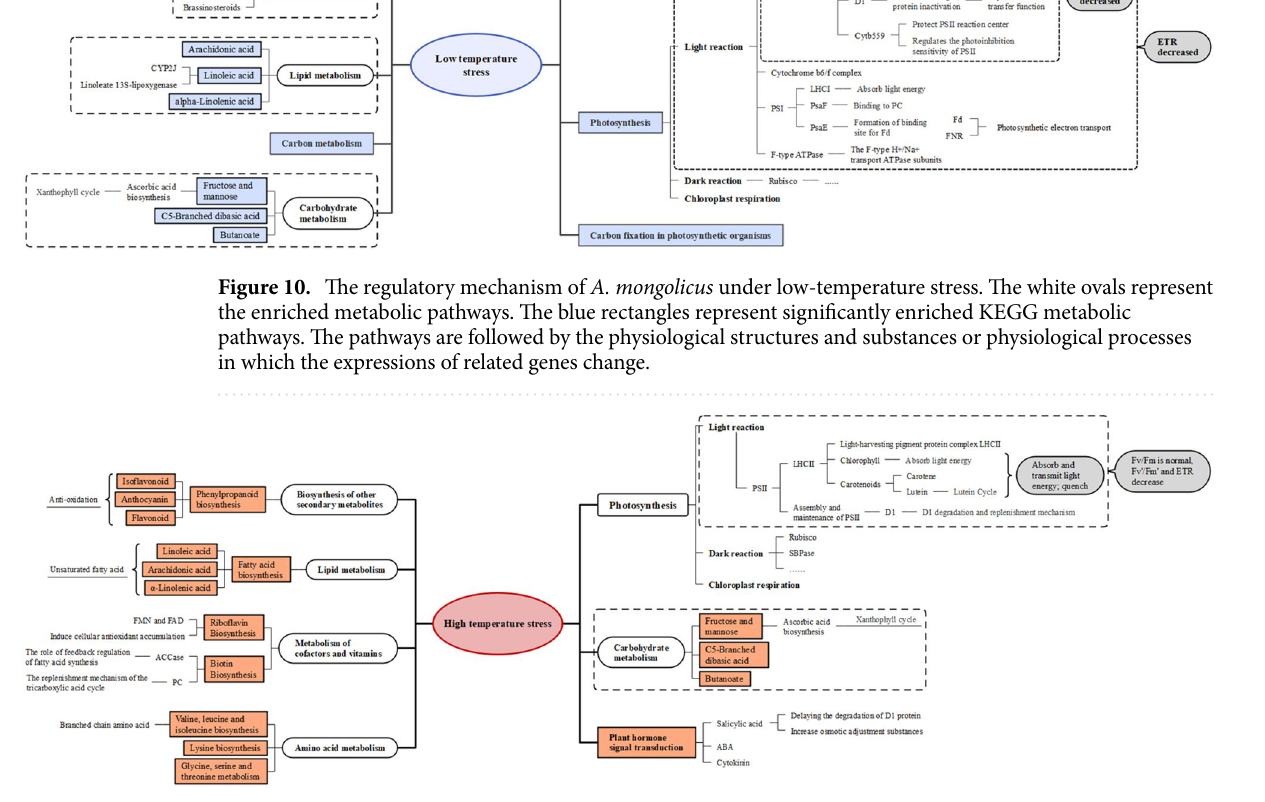
Figure 11. The regulatory mechanism of A. mongolicus. under high-temperature stress. The white ovals represent enriched metabolic pathways. The red rectangles represent significantly enriched KEGG metabolic pathways. The pathways are followed by the physiological structures and substances or physiological processes in which the expressions of related genes